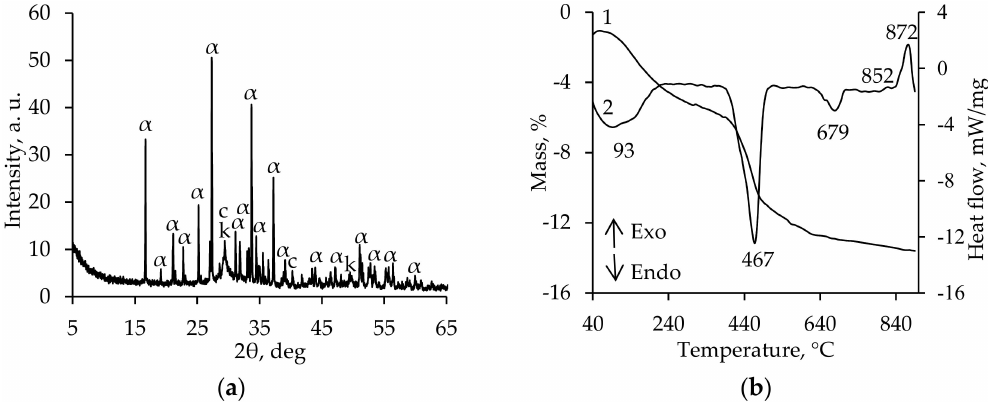
Figure 1. XRD pattern ( a ) and STA curves (Curve 1—TG; Curve 2—DSC) ( b ) of synthesis product. Indices: α — α -C 2 SH; c—CaCO 3 ;